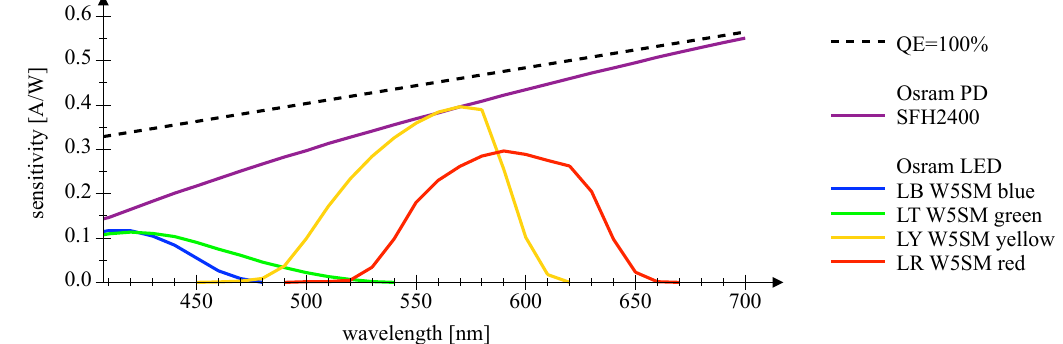
Figure 7. This plot shows spectral sensitivity measurements of Osram Golden Dragon series LEDs in four colors utilized as a photodetector. The measurements are compared with an Si PIN photodetector and its theoretical bound.